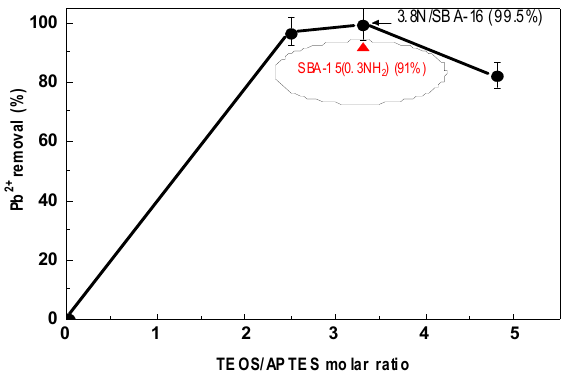
Figure 8. Influence of adsorbent/ligand molar ratio on the Pb 2+ adsorption onto SBA-16-based adsorbents. For comparison purposes, the SBA-15-based adsorbent prepared with tetraethyl orthosilicate/3-aminopropyltriethoxysilane (TEOS/APTES) molar ratio of 3.3 is included (from [1]). Conditions were: 20 mL of 200 mg L − 1 aqueous Pb 2+ solution, 0.10 g of adsorbent, pH = 5.0, contact time of 60 min, and T = 30 °C.